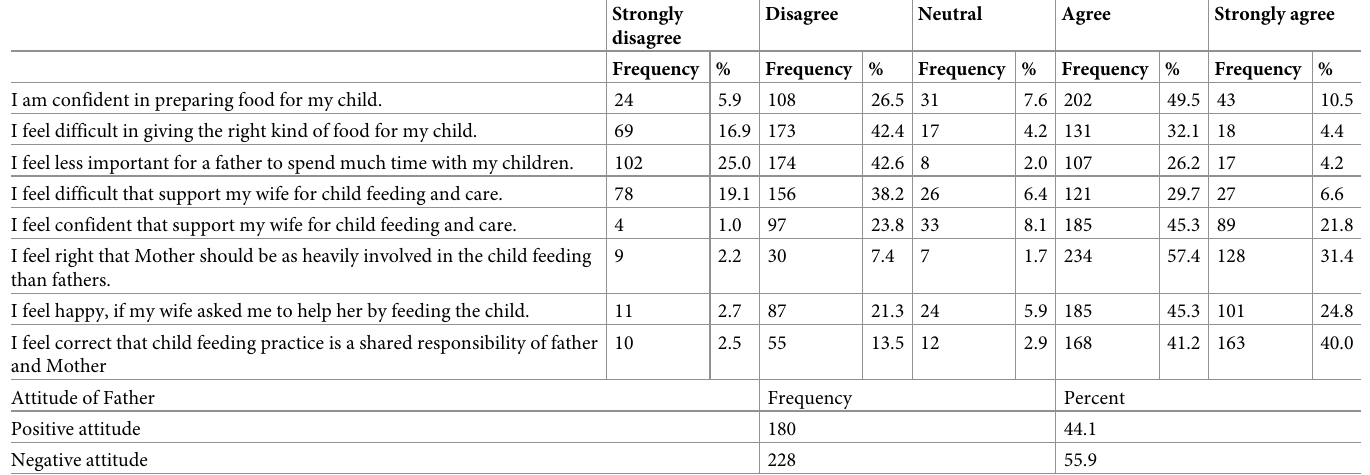
Table 3. Attitude of fathers about father involvement in child feeding in Antsokia Gemza Woreda, 2022.